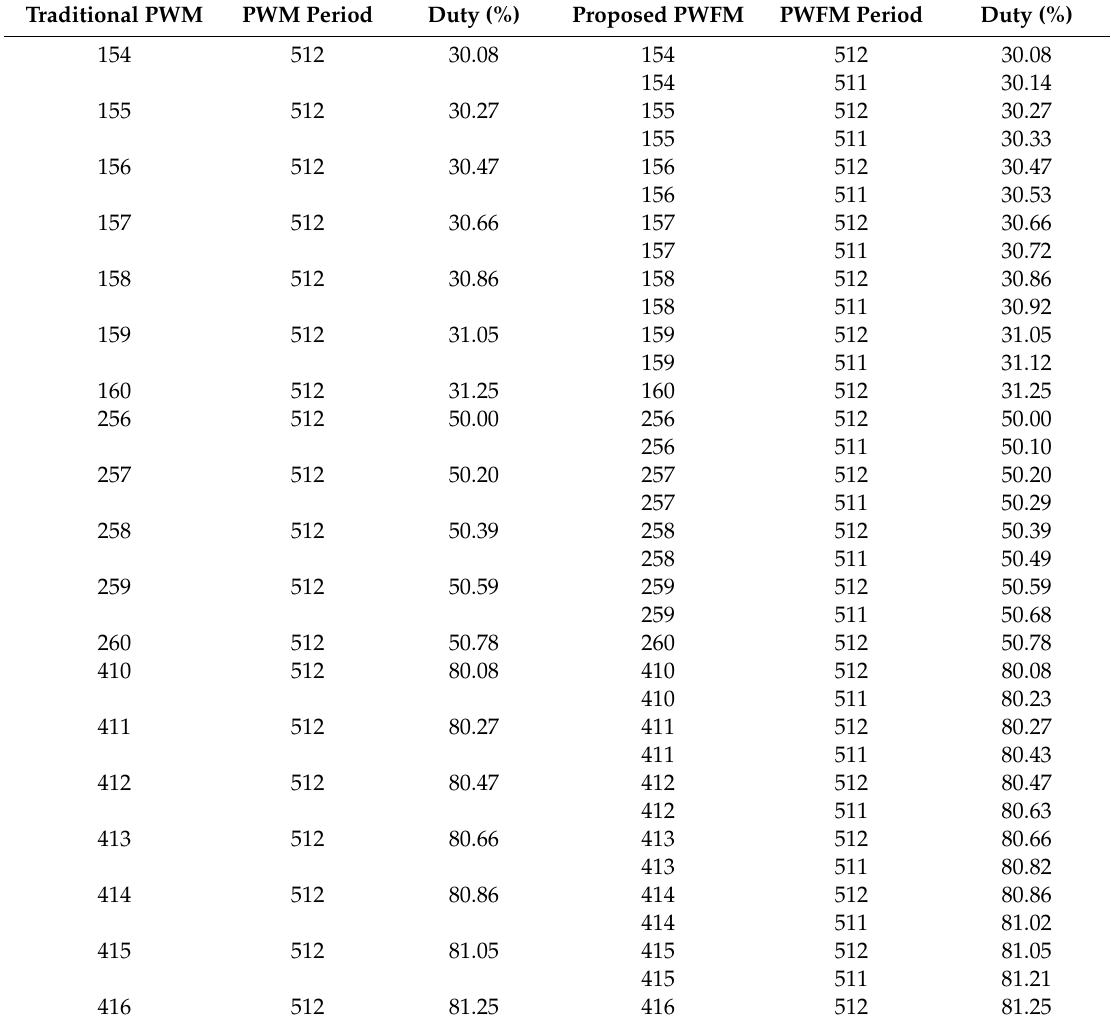
Table 1. Duty cycle comparison between (PWM) and pulse width and frequency modulation (PWFM). Traditional PWM PWM